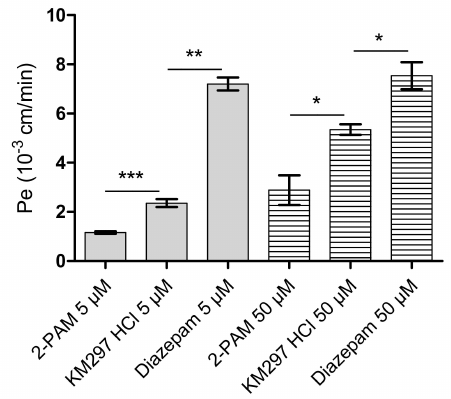
Figure 7. Endothelial permeability coe ffi cient (Pe) of 2-PAM, KM297 HCl, and diazepam measured in the human in vitro BBB model at 5 and 50 µ M. Values are presented as mean ± SEM, n = 3–12. Comparisons were performed using Mann–Whitney test between KM297 HCl and 2-PAM or diazepam.